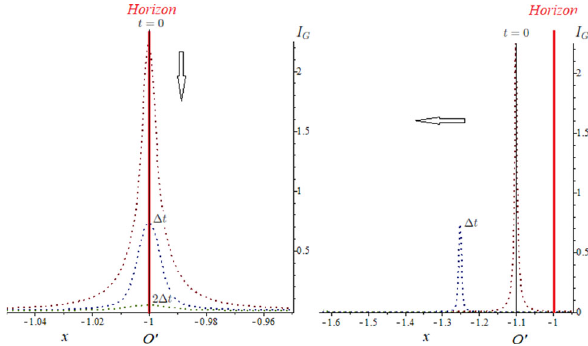
Fig. 3 Horizon effects of the Gaussian wave packet with a 3 = 0 . 009 and ¯ k 3 = 100 plotted at consecutive epochs with (cid:6) t = 0 . 9197. In the left panel the intensity of the wave packet prepared on horizon remains static while the packet prepared beyond the horizon appears as being